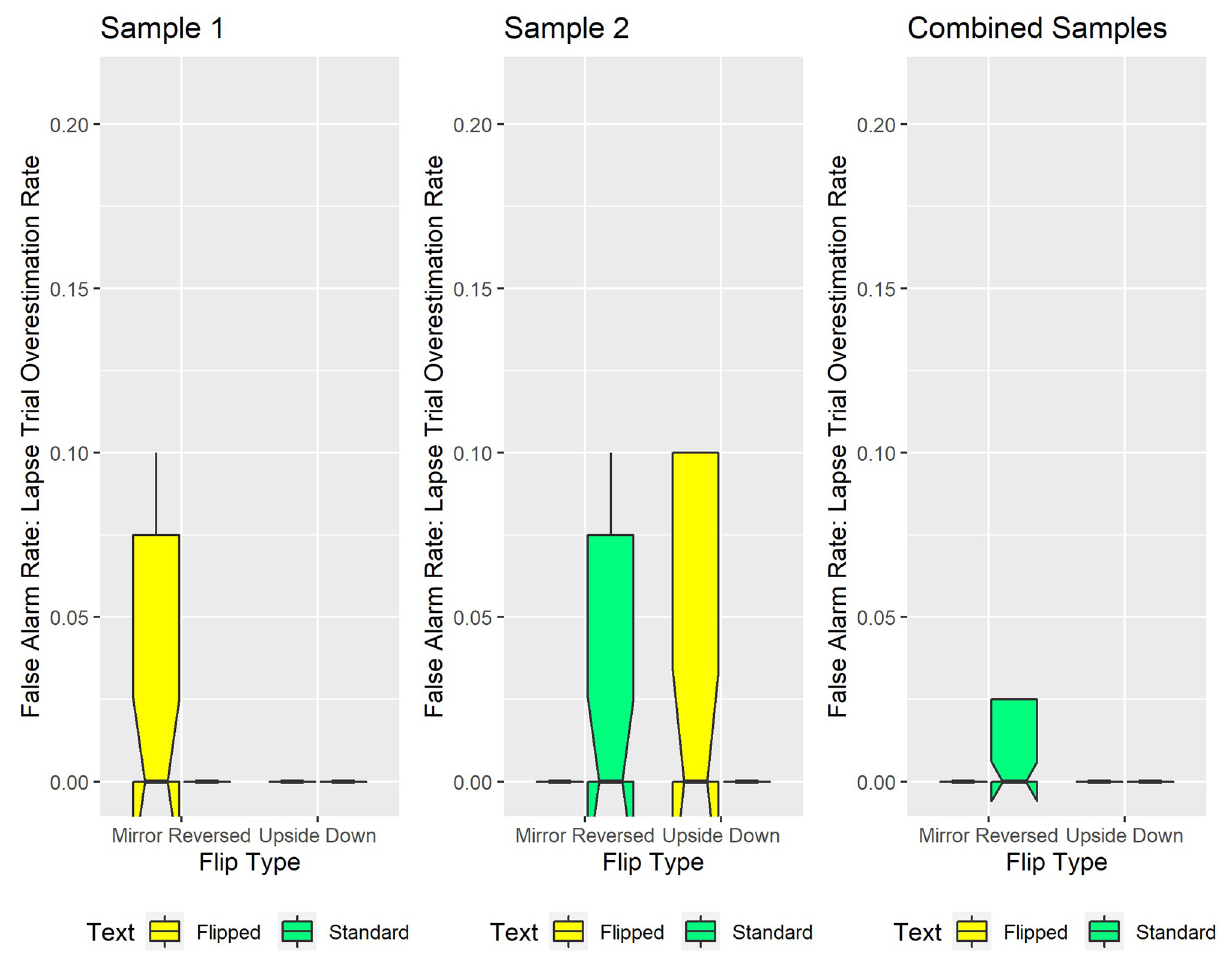
Fig 9. Lapses that reflect sentence length overestimates. The ordinate reflects the proportion of trials when participants overestimated sentence length, incorrectly classifying 10-word or 11-word sentences as having “More-Than-17-Words”. Median overestimation rates remained identical and low (0% of trials) across experimental conditions. Some conditions produced distributions skewed such that the 25th percentile equaled the median. Those conditions show downward-pointing protrusions. Conventions remain the same as in Fig 5.